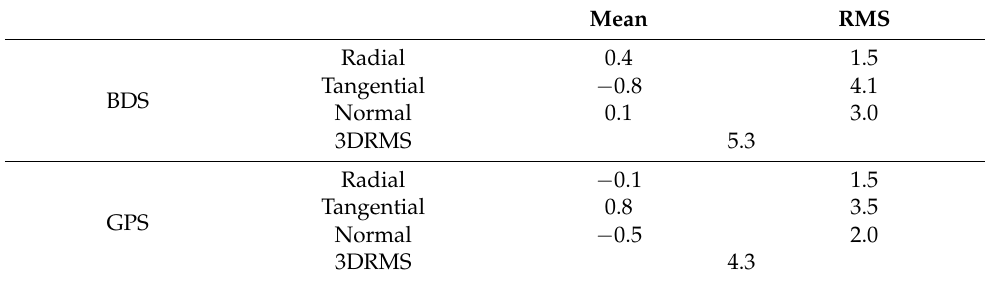
Table 5. Accuracy statistics of POD for HY2D using spaceborne BDS and GPS data (unit: